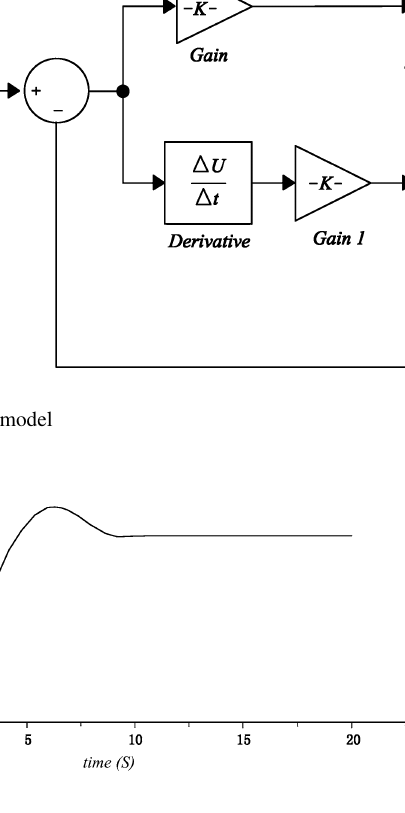
Fig. 9 Unit step response curve of fuzzy control model